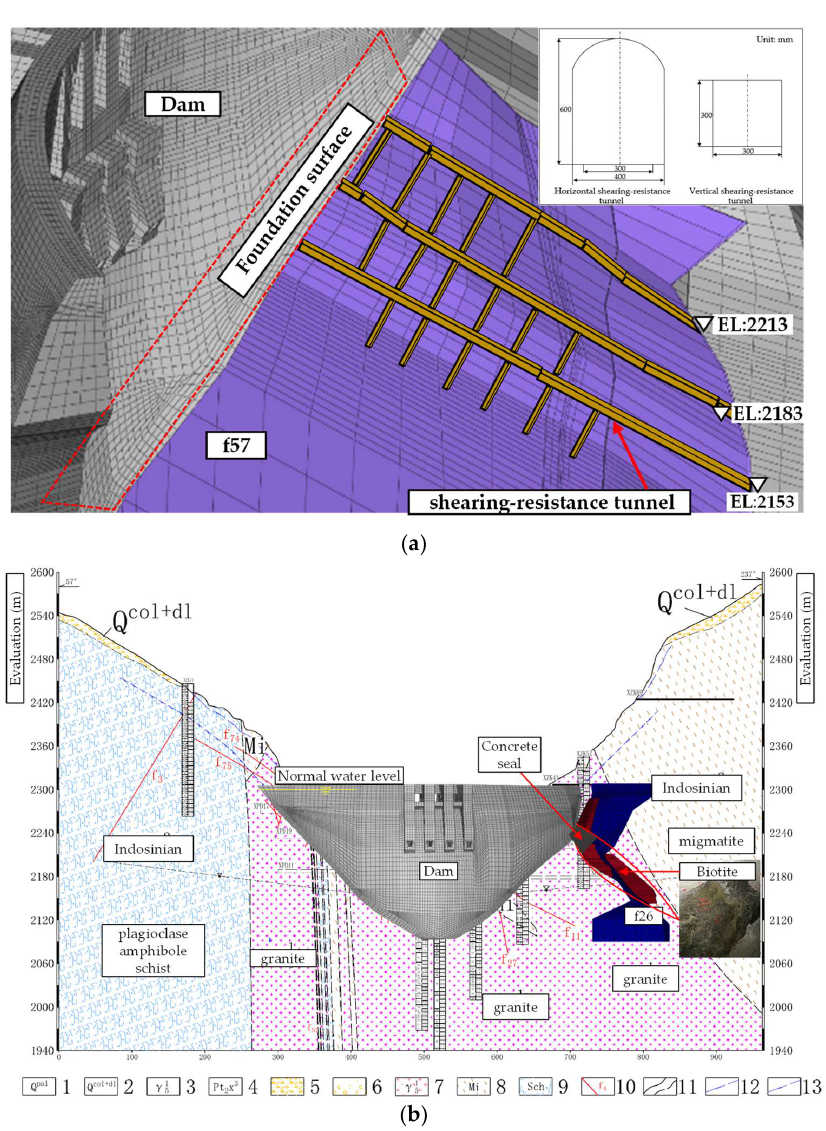
Figure 15. The abutments reinforcement method of the Xulong arch dam. ( a ) Shearing-resistance tunnel for the left abutment; ( b ) concrete replacement for the right abutment.